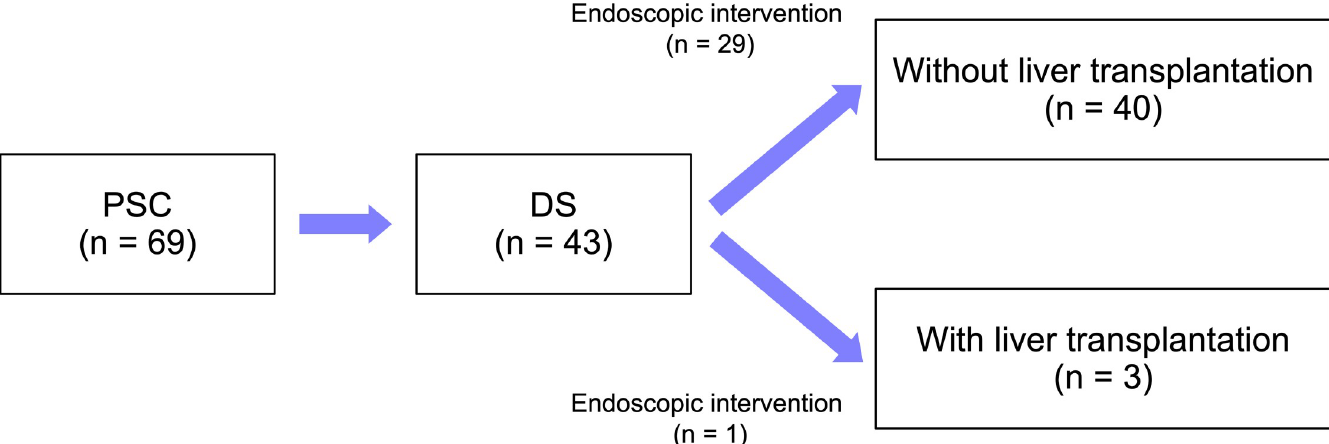
Fig 2. Progression from initial diagnosis to DS in 69 patients with PSC. DS, dominant stricture; PSC, primary sclerosing cholangitis.